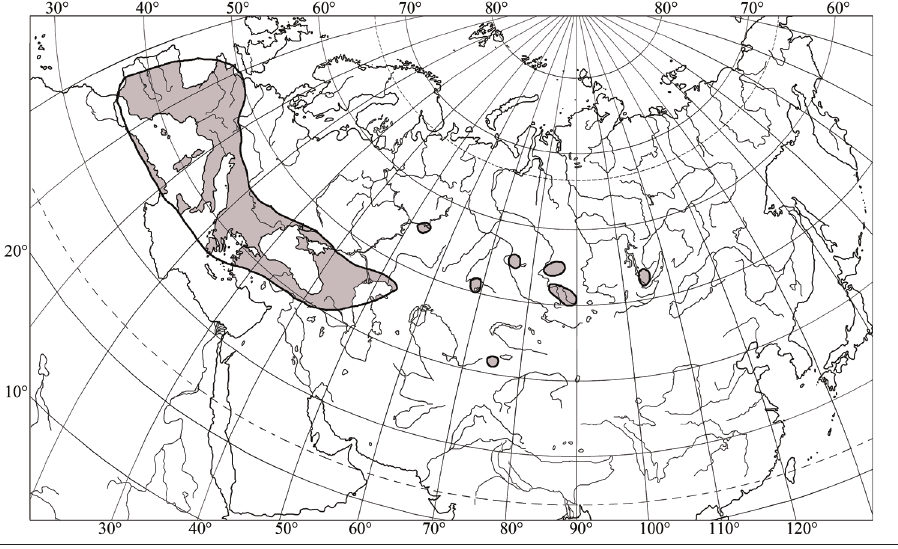
Figure 4. Range of Eurygaster dilaticollis Dohrn, 1860 (after Göllner-Scheiding 2006 and Vinokurov et al.